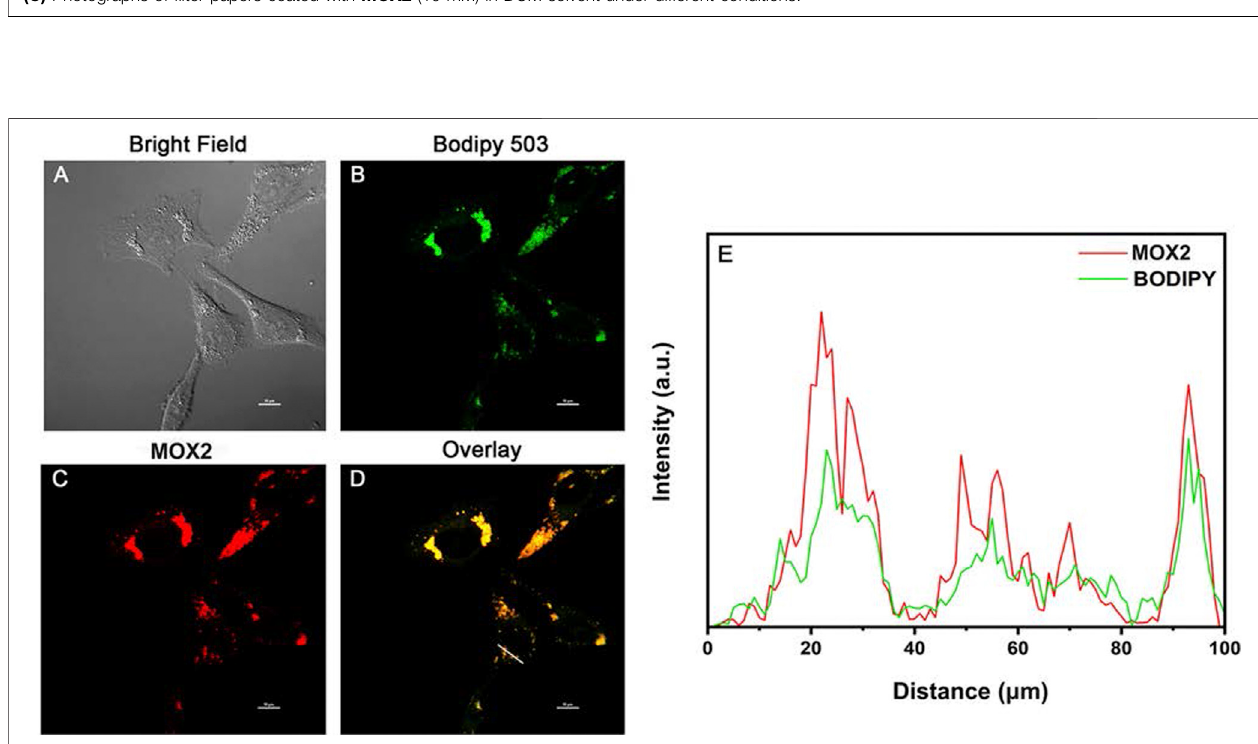
FIGURE9| ColocalizationconfocalimagingoflivingHeLacellsstainedwith MOX2 andBODIPY503: (A) bright fi eldimage; (B) imagingchannelofBODIPY503( λ ex (cid:1) 488 nm; λ (cid:1) 500 – 540 nm); (C) imagingchannelof MOX2 ( λ em the fl uorescence of MOX2 and BODIPY,